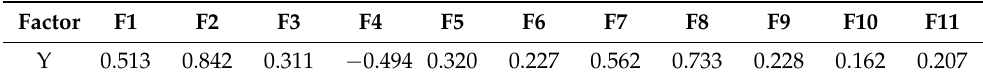
Table 6. Pearson correlation coefficient among